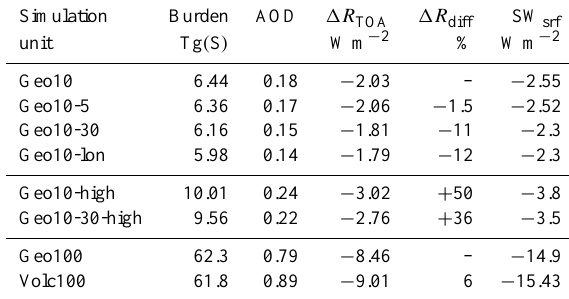
Table 2. Burden, AOD, (cid:49)R TOA (net SW + LW), and net surface SW radiation for the different simulations. (cid:49)R diff is the relative difference of (cid:49)R TOA to Geo10 and Geo100. Geo10 and Geo100 follow the design of GeoX (Table 1) with injection rates of 10 and 100Tg ( S ) yr − 1 .